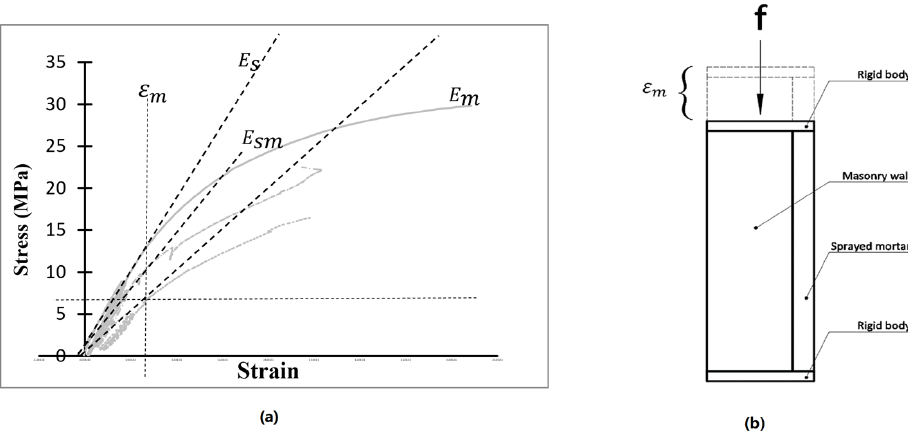
Figure 13. ( a ) Stress-strain diagram of the behavior of a compressed composite wall at the same strain; ( b ) Schematic representation of the behavior of a compressed composite wall under the same strain; 𝐸 (cid:3046) : Secant modulus of sprayed mortar corresponding to the strain 𝜀 (cid:3040) ; 𝐸 (cid:3040) : Secant modulus of masonry wall corresponding to the strain 𝜀 (cid:3040) ; 𝐸 (cid:3046)(cid:3040) : Secant modulus of composited wall corre- sponding to the strain 𝜀 (cid:3040) ; 𝜀 (cid:3040) : Strain at the one-third ultimate strength of the masonry wall.